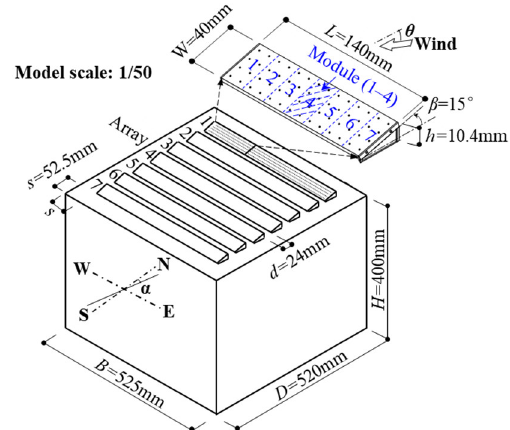
Figure 4. Experimental model of flat-roof-mounted solar arrays (NOTE: The module is designated by (row number-module number)).